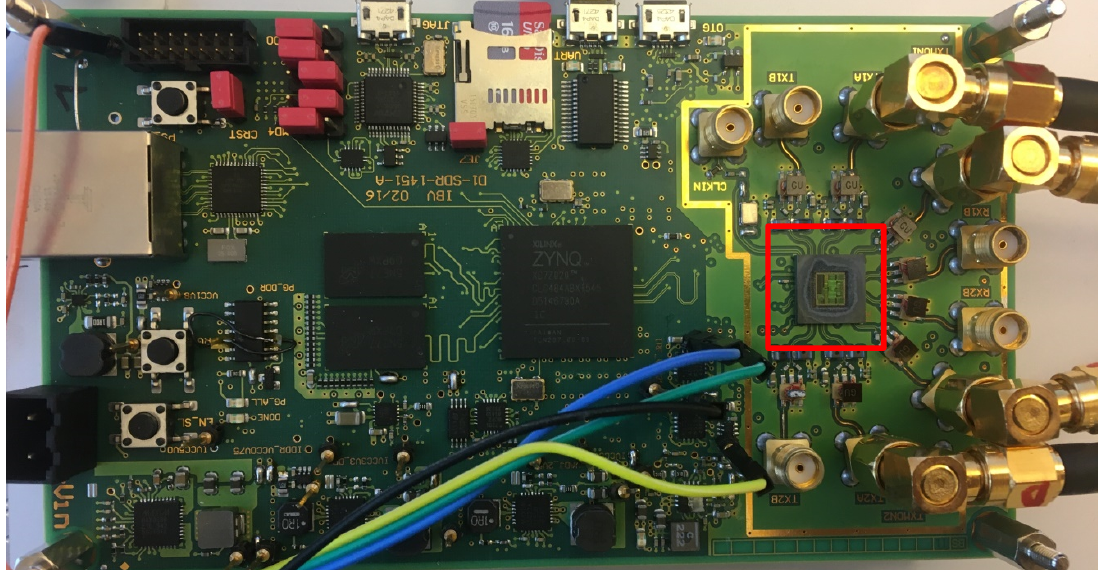
Figure 5. Picture of the test board for the heavy ion test with the acid etched DUT on the right-hand side.